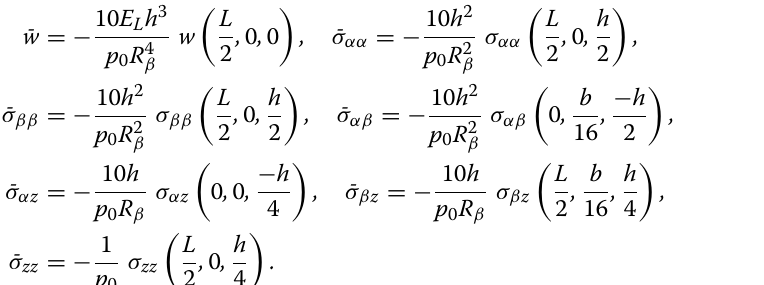
πα 4 β p ( α , β ) = − p 0 sin cos L R β where L is the cylinder length and R β the middle surface radius, and L = 4 R β . Figure 7a, b illustrate the axial variation and the sectional profile of the pressure load,